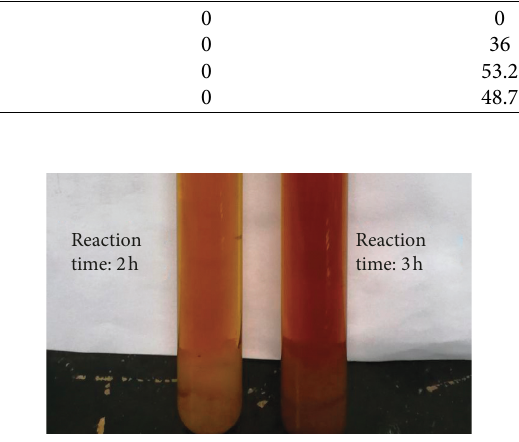
Figure 10: Color contrast diagram of reaction solution with different reaction times. Table 5: Effect of catalyst dosage on the phenol hydroxylation.